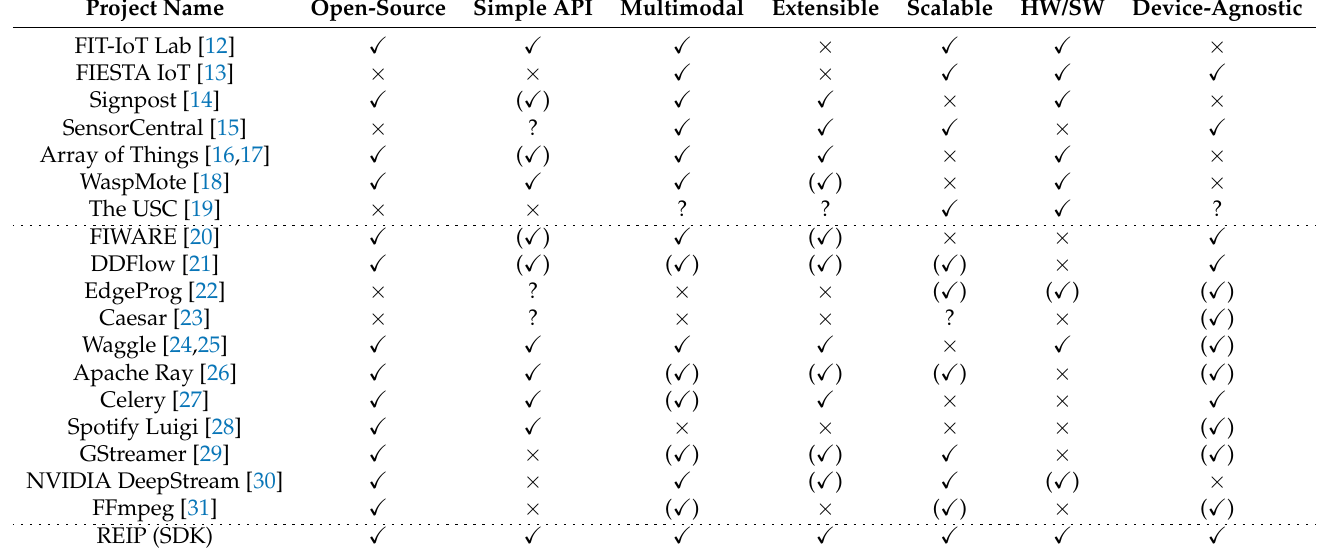
Table 1. Related works feature comparison. The features include (from left to right): open source availability; user-friendly API/low barrier for entry; support of multiple sensing modalities; ability to easily add new features or sensing modalities (extensible); ability to handle large amounts of data (scalable); sensor level integration (HW/SW); and whether the framework can be used with various computing platforms and sensor devices (device-agnostic). The (cid:88) and × symbols denote whether the feature is present or not in each framework. The parenthesis indicate that the feature is present in the given framework but it does not excel at it, or that the framework could possibly be used but it was not designed to have such feature. A question mark means no assessment.